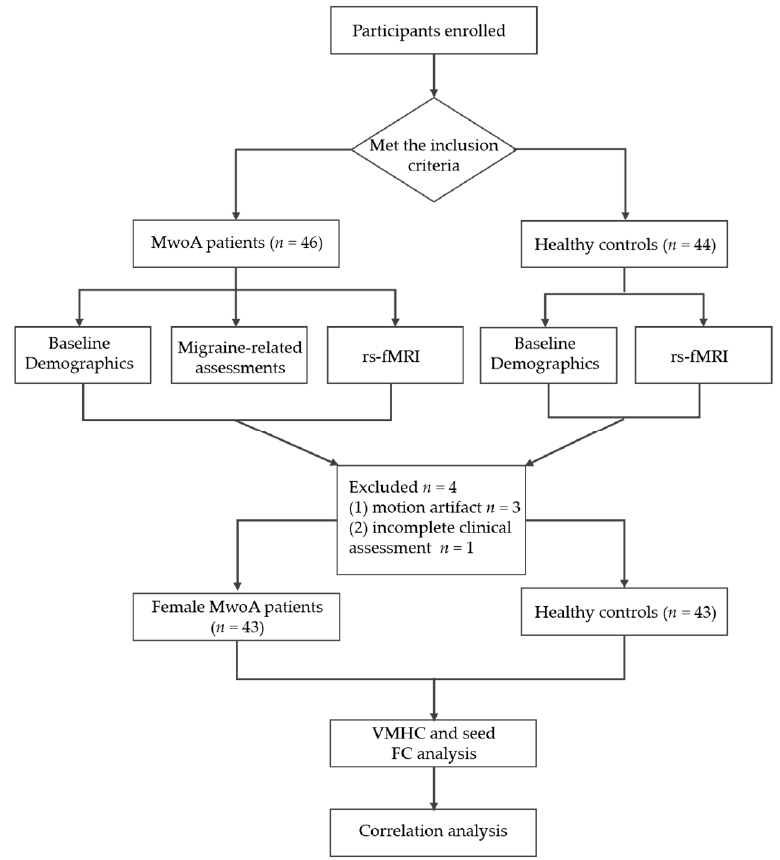
Figure 1. Study design flow chart.